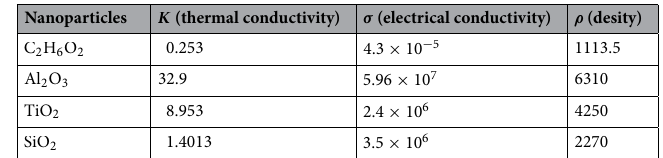
Table 1. Thermal properties for ethylene glycol, aluminium oxide, titanium dioxide and silicon dioxide in [33 and 34].